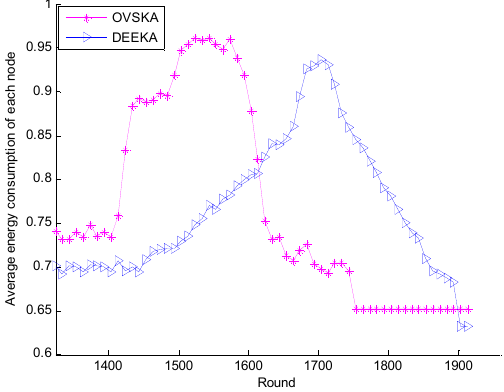
Figure 12. Average energy consumption of each node with the number of network running rounds.